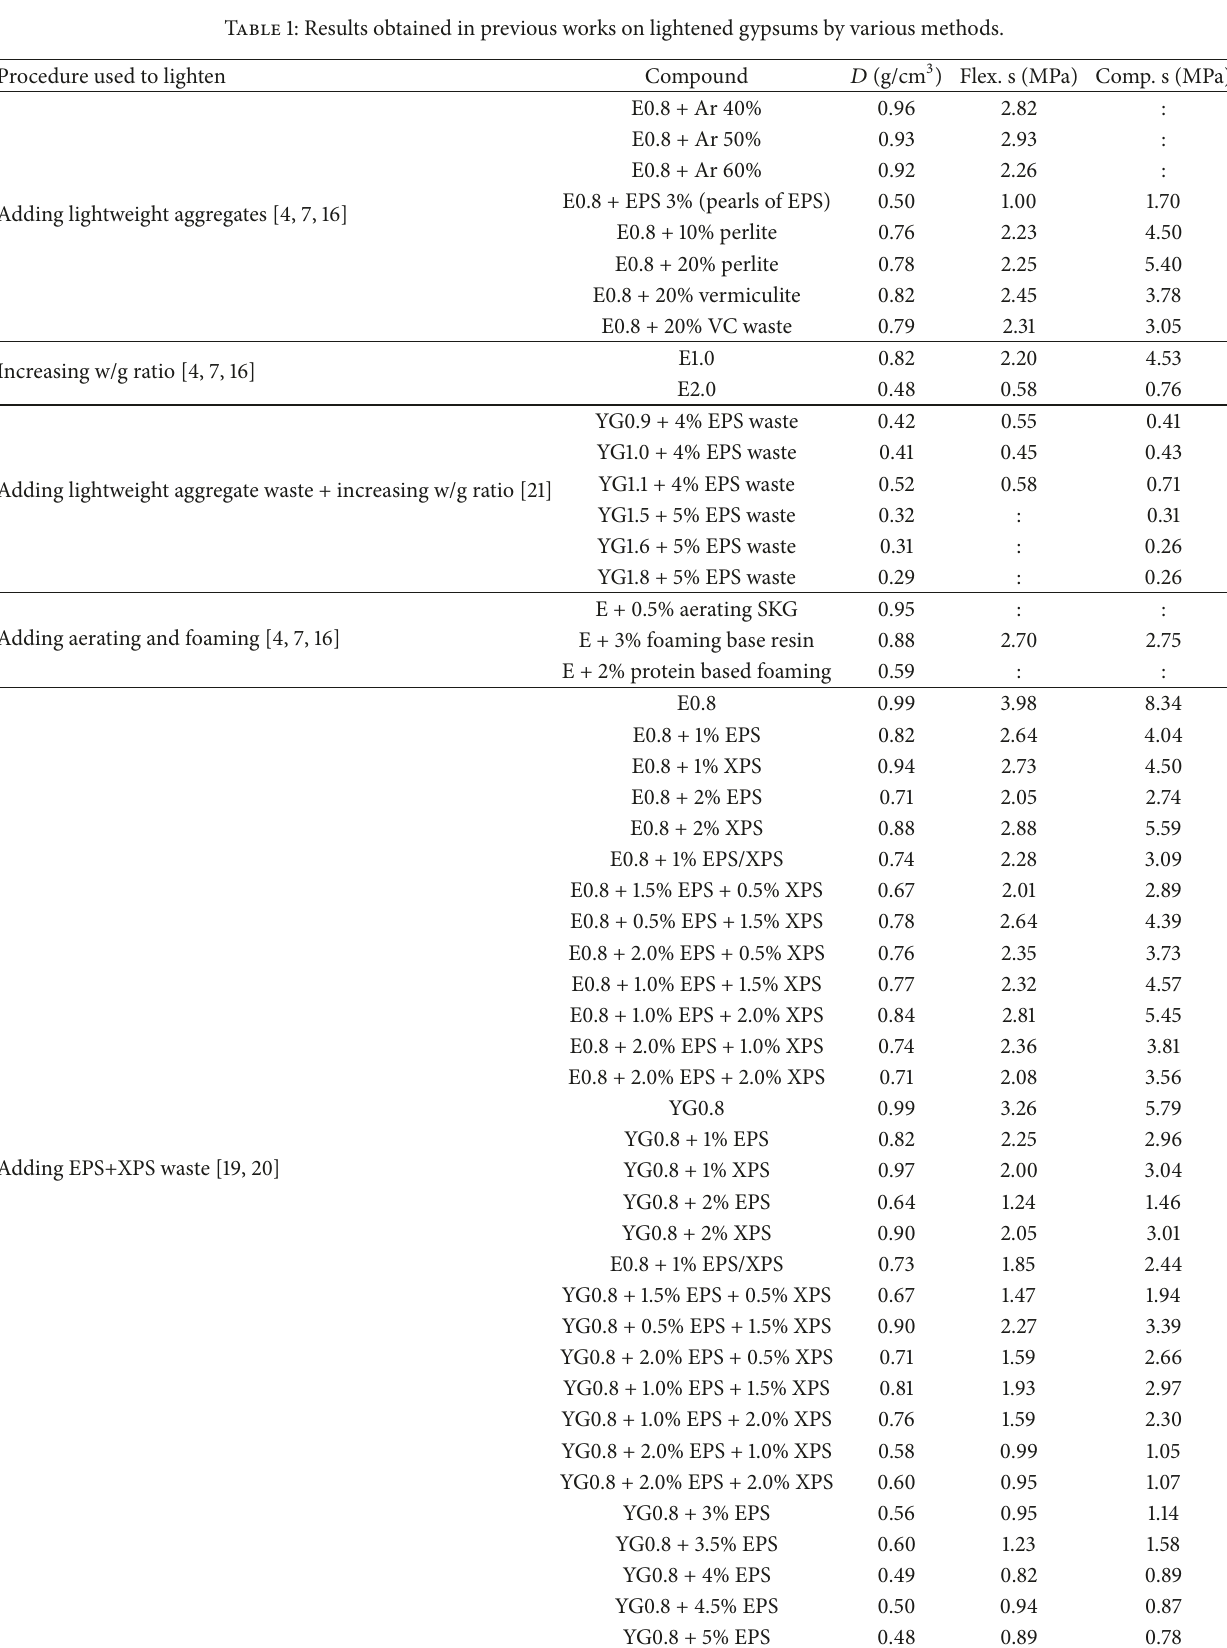
Table 1: Results obtained in previous works on lightened gypsums by various